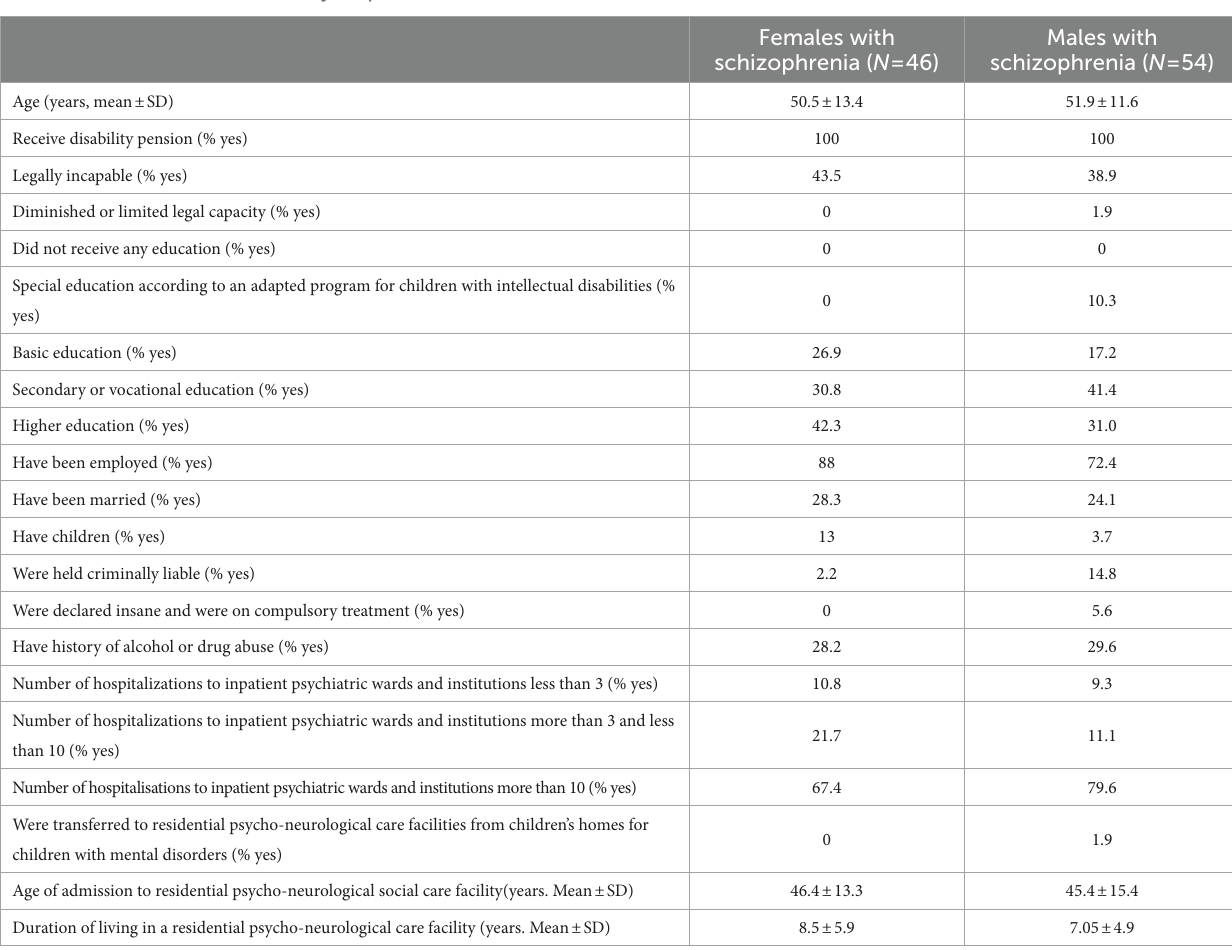
TABLE 1 The characteristics of the study